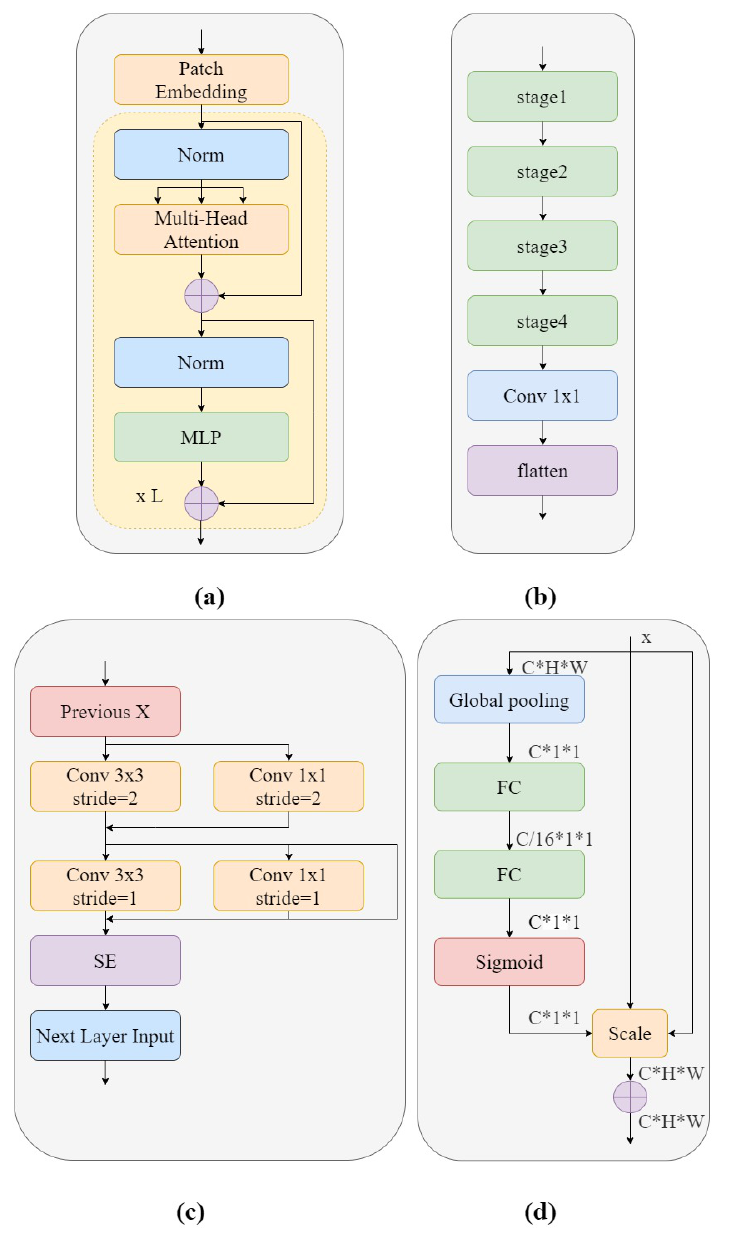
Figure 4. ( a ) The structure of the transformer encoder; ( b ) ViT-P patch embedding; ( c ) Detailed structure of each ViT-P patch embedding stage; ( d ) SE